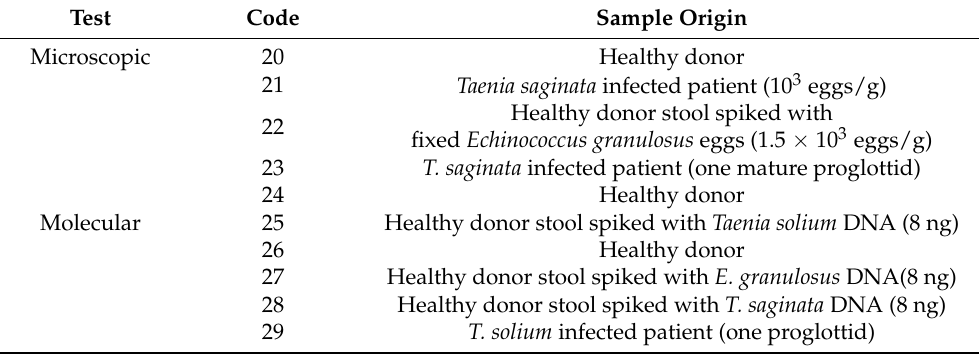
Table 3. Panel of stool samples provided for the coprological Ring Trials. Test